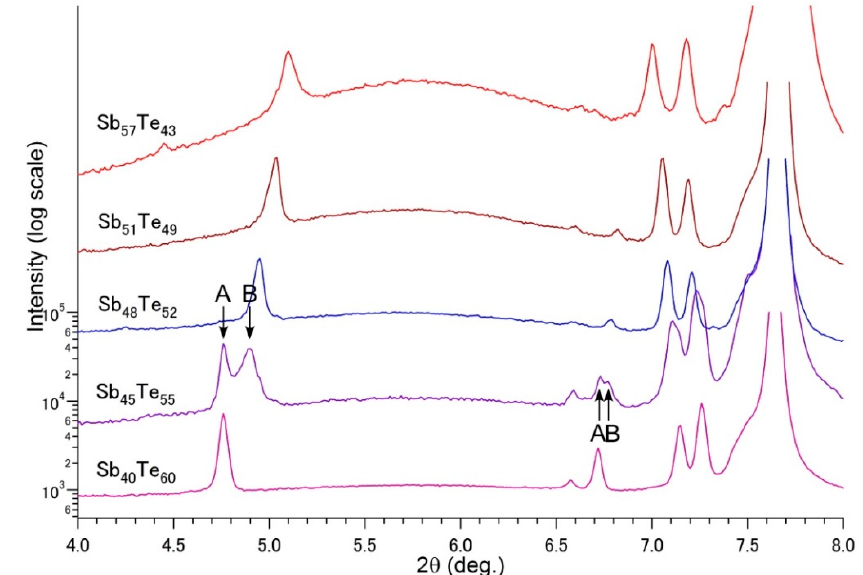
Figure 2. X-ray powder diffraction profiles of Sb–Te specimens acquired at 90 K.